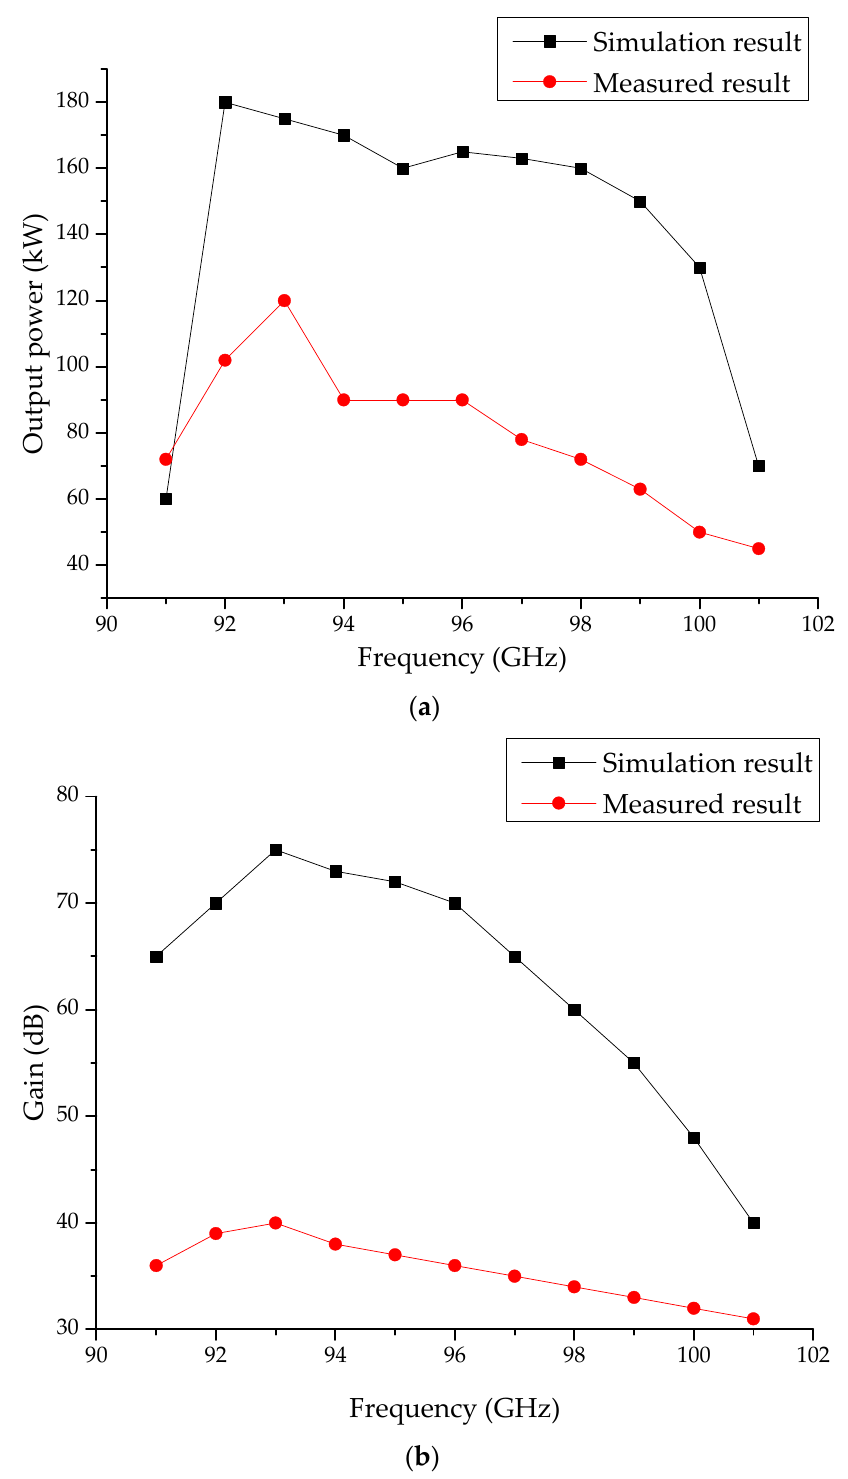
Figure 15. Measured output power ( a ) and gain ( b ) of the W-band TE 02 mode gyro-TWT.